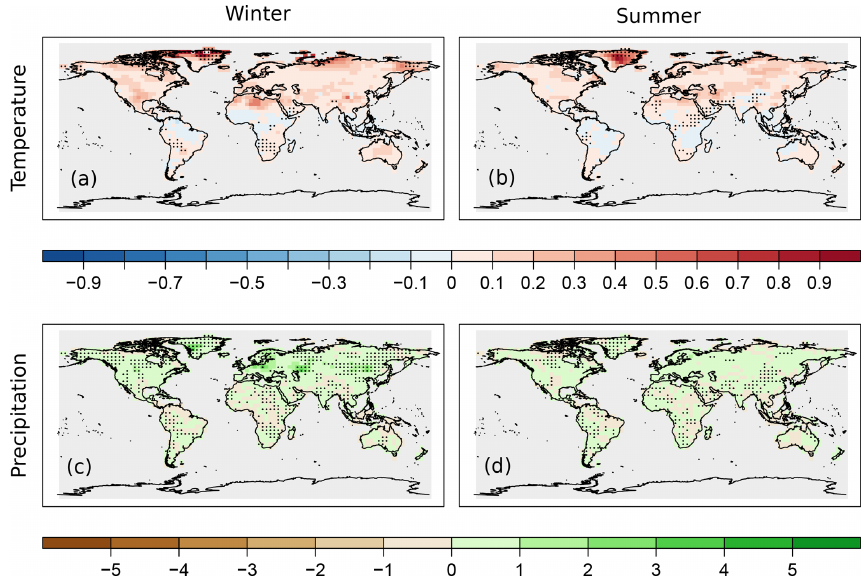
Figure 9. Difference of the RE skill between the temporally localized experiment and the original setup, when only instrumental data are assimilated. Temperature (a, b) and precipitation (c, d) differences are shown in the winter (a, c) and in the summer (b, d) seasons. The black dots indicate the negative RE values in the temporally localized